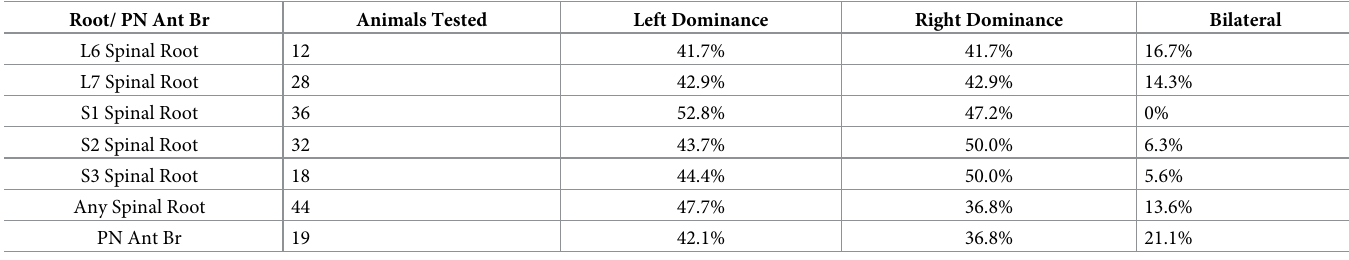
Table 1. Redefining lateralization as 10% difference between left and right spinal root (L6-S3) or anterior visceral branch of the pelvic nerve (upon stimulation).